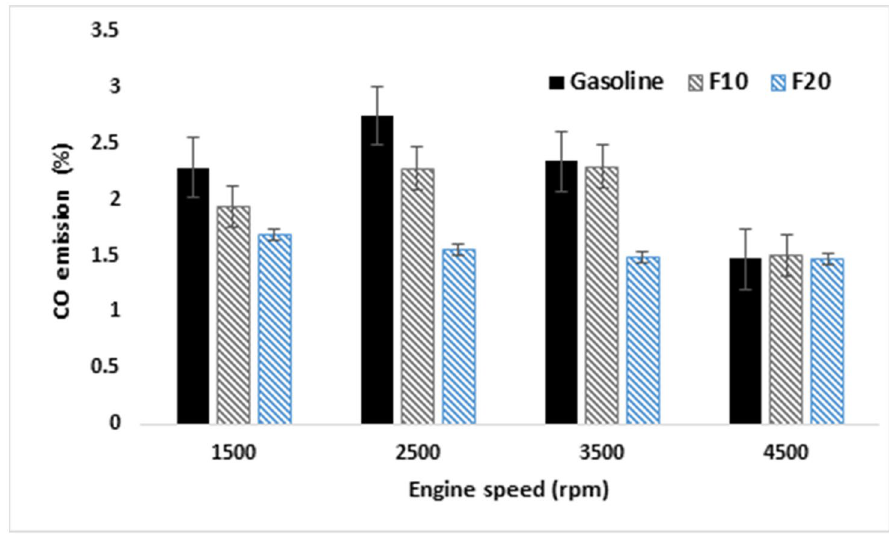
Figure 13. CO emissions variation with increasing engine speed.